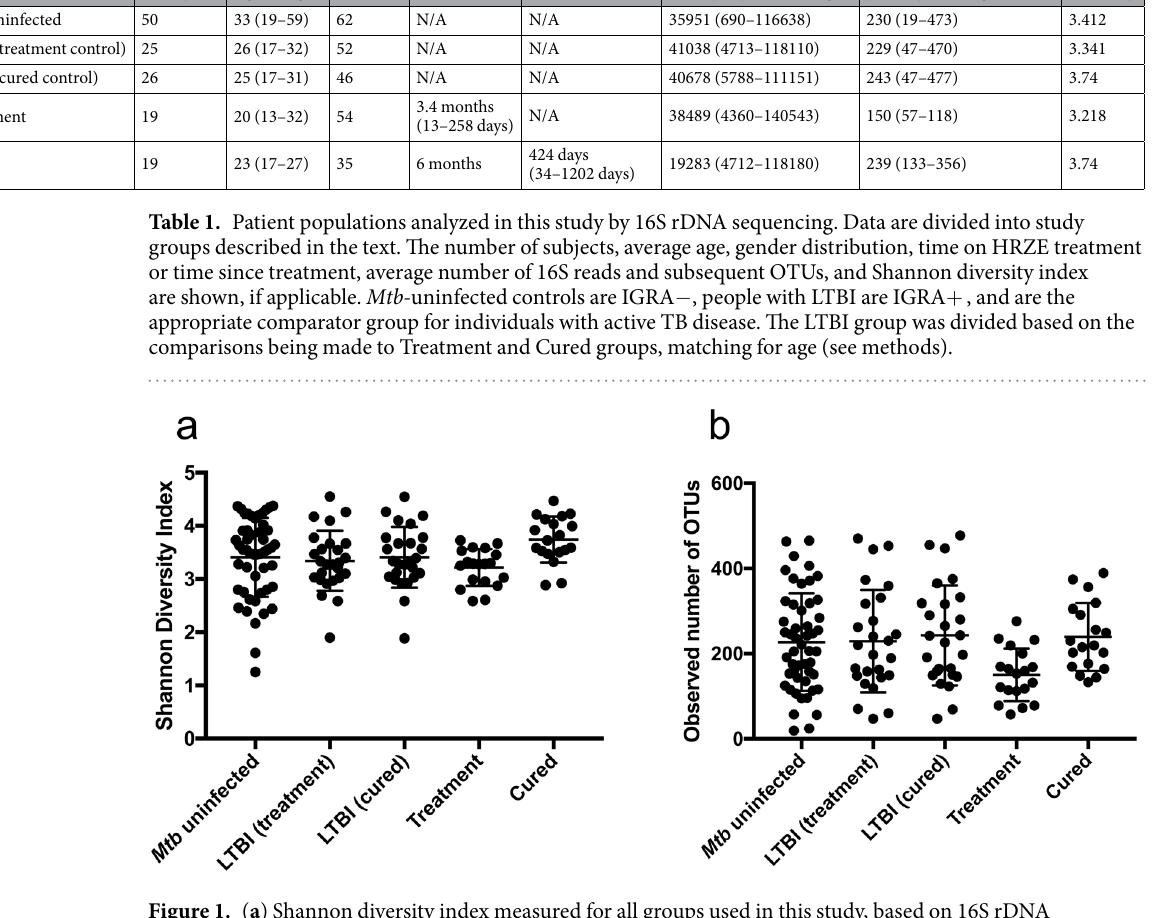
Figure 1. ( a ) Shannon diversity index measured for all groups used in this study, based on 16S rDNA sequencing data. The LTBI (treatment) group indicates subjects who are the age-matched controls for the treatment group, and the LTBI (cured) group indicates the age-matched controls for the cured group. ( b ) Raw number of observed OTUs clustered at 97% similarity for the indicated